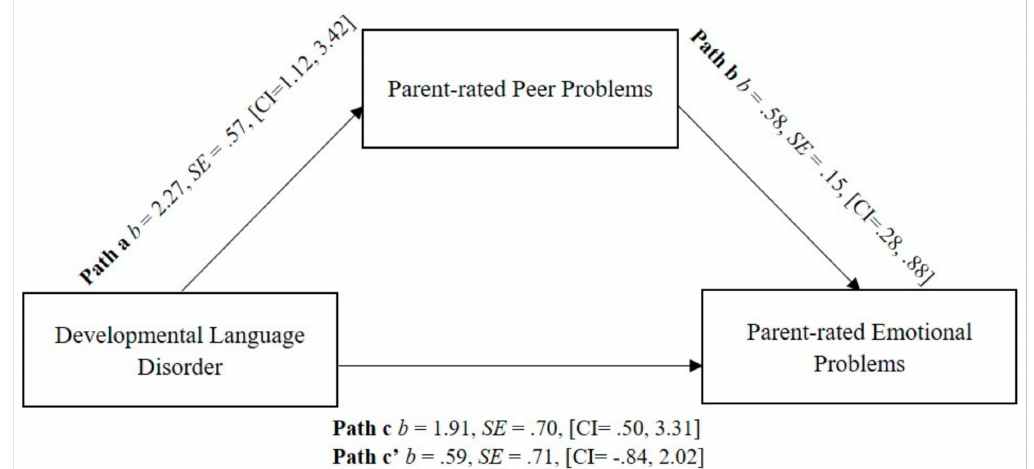
Figure 3. Regression coefficients for the relationship between Developmental Language Disorder (DLD) and parent-rated emotional problems as mediated by parent-rated peer